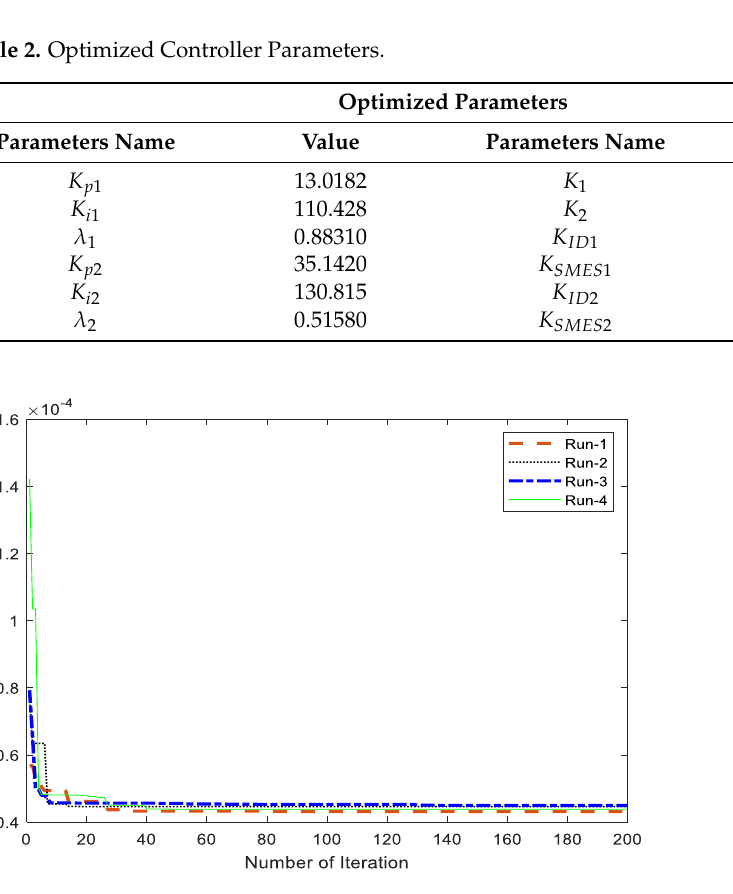
Optimized Parameters Parameters Name